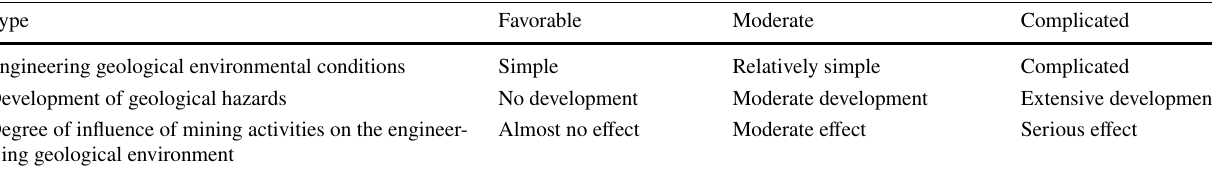
Table 2 Grading evaluation of the engineering geological environments of deep seabed mining sites